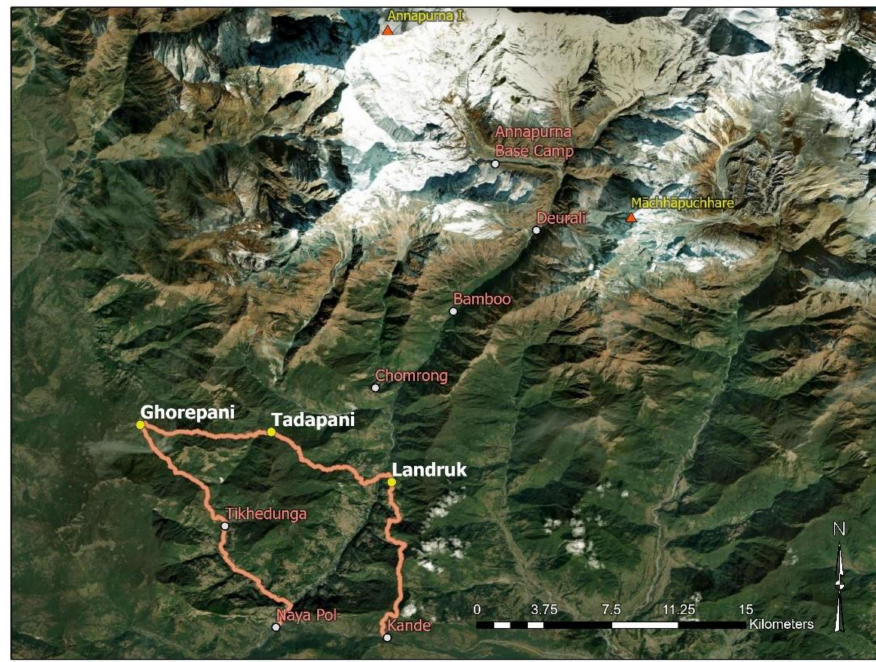
Figure 1. Trekking route starting at Naya Pol showing Ghorepani (2874 m), Tadapani (2610 m), and Landruk (1628 m) where indoor and outdoor air pollution samples were collected. Annapurna I (8091 m) and Machhapuchhare (6993 m) are shown for